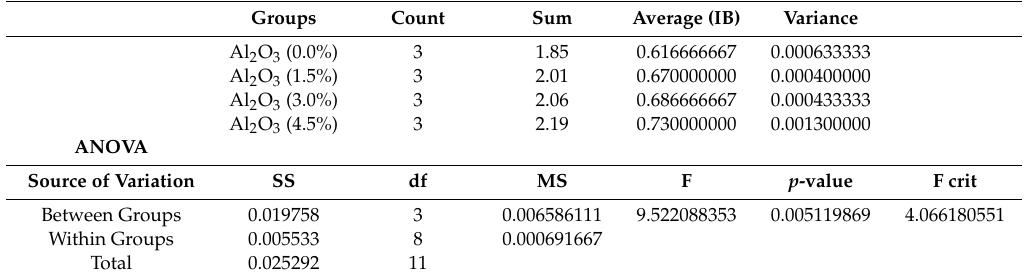
Table 3. Internal Bonding values of Al 2 O 3 -UF MDF for various treatments.